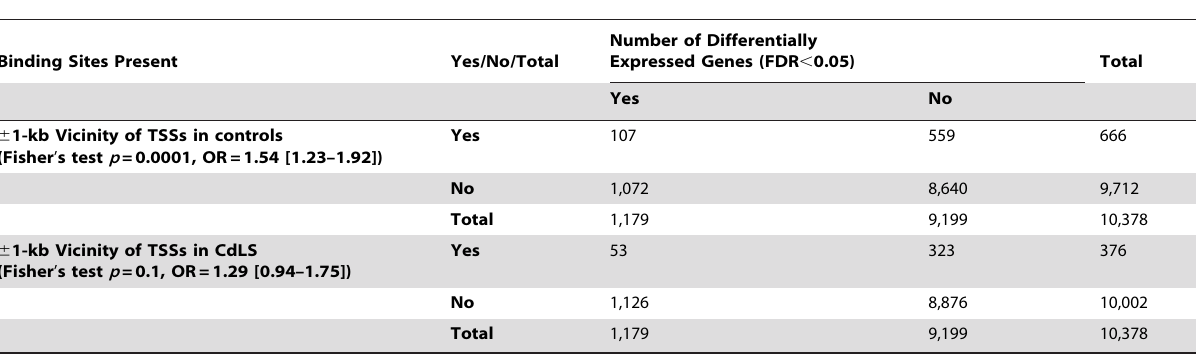
Table 2. Differentially expressed genes tend to lose their cohesin binding at TSSs in CdLS samples.